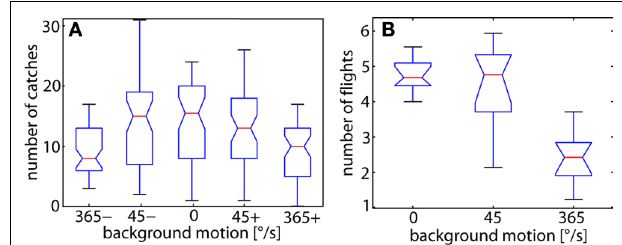
conditions. For each background condition the catches were counted in 50 time-windows (each lasting 40 s). The background was either moving slowly ( 45 ° /s) or quickly ( 365 ° /s) in the same ( positive sign ) direction as or in the opposite ( negative sign ) direction to the target. As a reference, the background was held stationary ( 0 ° /s). The catching frequency is signifi cantly decreased at high background velocities with reference to the number of captures obtained while the background was stationary (Wilcoxon signed rank test; P < 0.01). Catches: n = 2954. (B) Number of fl ies fl ying simultaneously at any time in the arena under the three different background conditions. The background was either stationary (0 ° /s, reference), or moved at 45 ° /s or at 365 ° /s (positive and negative direction values pooled). The number of fl ies fl ying was determined during each 1 s time bin of a 30-s time-window and averaged over the 30-s time-window. The averages shown in the fi gure are obtained from 10 trials. Since fl ight sequences usually last for only few seconds, many different fl ies fl ew during the counting period even if the mean number of fl ying fl ies at each instant of time ranges, on average, only between 5 and 2. The number of fl ights was found to be signifi cantly smaller at the high background velocity with reference to the stationary background (Kruskal–Wallis test; P < 0.01). 1 s time-bins: n = 1800.